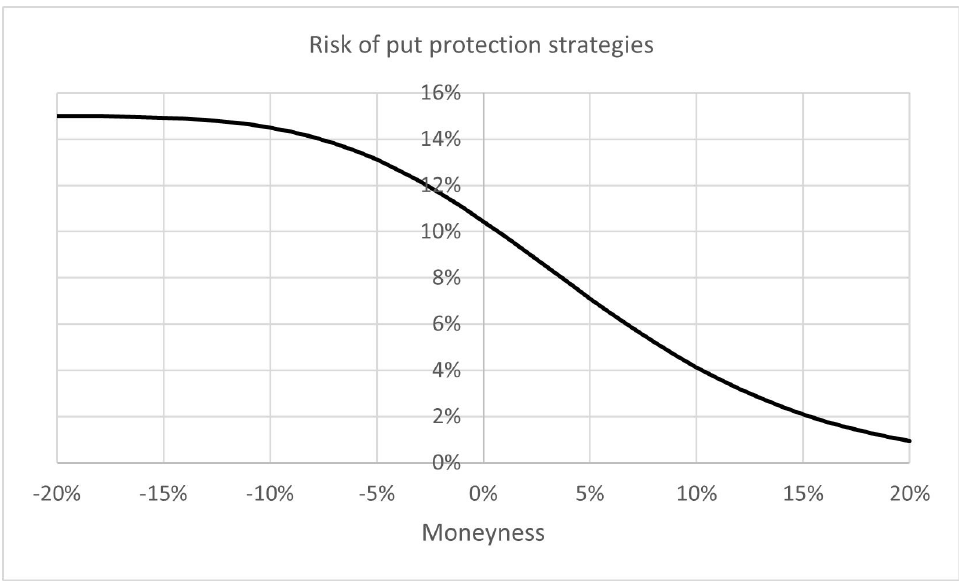
Figure 11. The risk of the return of an underlying asset with an overlaid put protection strategy for a range of strike prices.